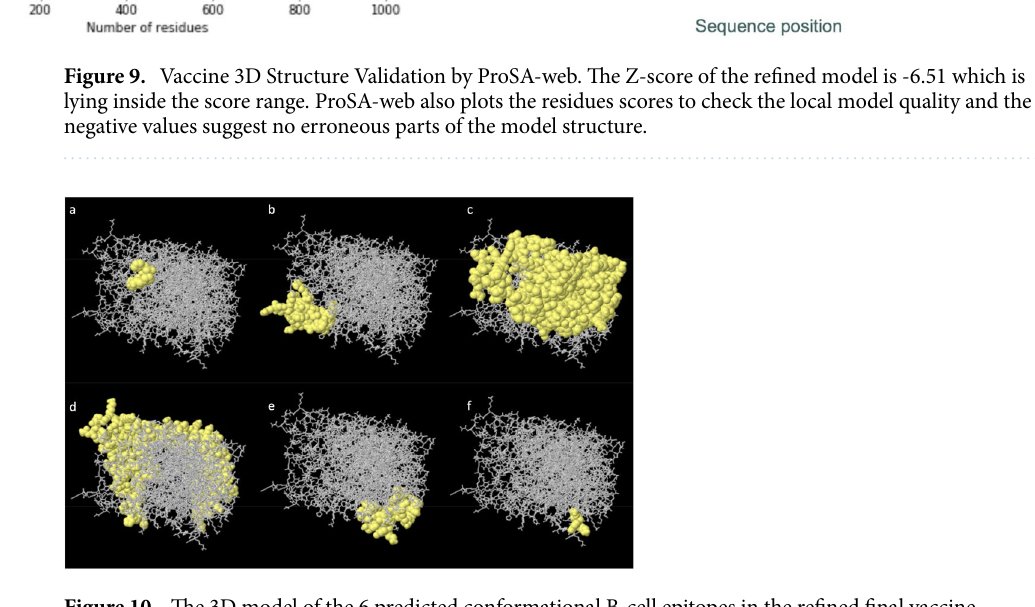
Figure 10. The 3D model of the 6 predicted conformational B-cell epitopes in the refined final vaccine structure. The yellow parts are the conformational B-cell epitopes and the grey parts are the rest of the residues. (a) 3 residues with a score of 0.963. (b) 30 residues with a score of 0.757. (c) 167 residues with a score of 0.711. (d) 161 residues with a score of 0.688. (e) 23 residues with a score of 0.59. (f) 3 residues with a score of